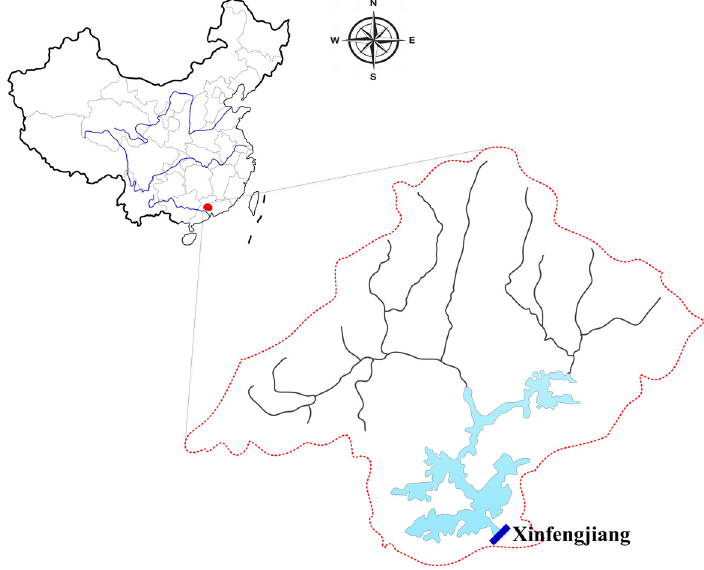
Figure 1. Location of the study area and Xinfengjiang